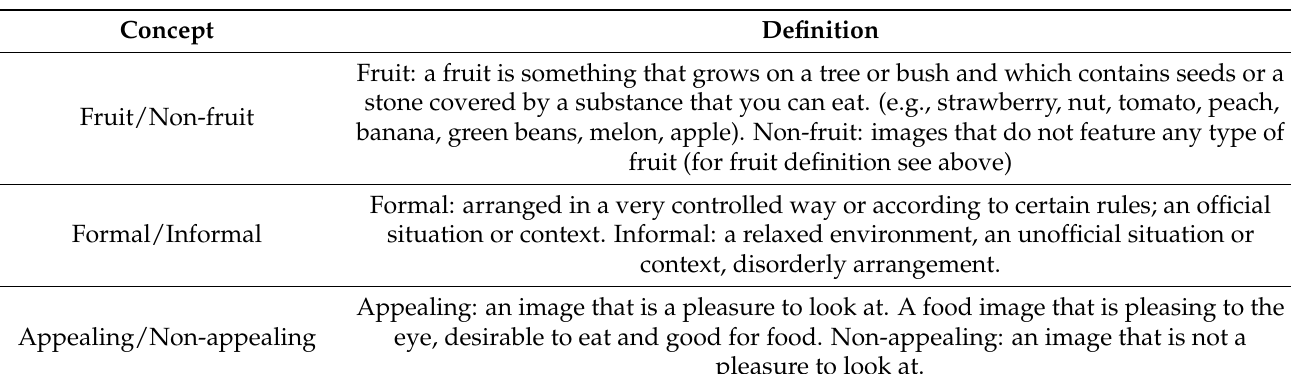
Table 3. The definitions used for Round-2 ChIA image